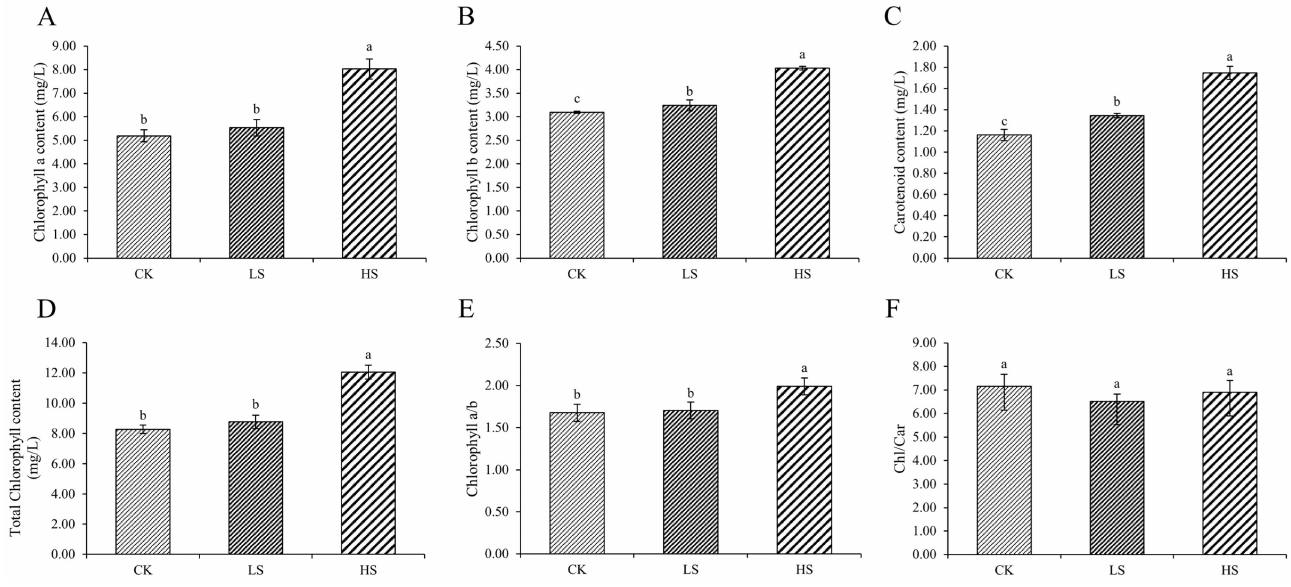
Figure 3. Changes in pigments in P. koraiensis under light stress. ( A ) Chlorophyll a content. ( B ) Chlorophyll b content. ( C ) Total chlorophyll content. ( D ) Carotenoid content. ( E ) Chlorophyll a/b. ( F ) Chlorophyll/Carotenoid. CK: control. LS: light shade. HS: heavy shade. The error bars represent the standard error. Different letters indicate significant differences among different